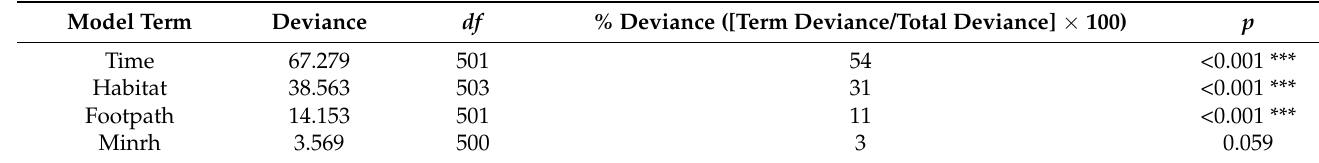
Table 3. Model effects for explanatory variables predicting dog ( Canis lupus familiaris ) presence/absence from point count transect data across 7 study sites in Brighton and Hove and surrounding areas, England, UK. Time = time of day (morning, day, evening); Habitat = habitat type (hardstanding, amenity grassland, natural grassland, woodland/scrub); Minrh = minimum relative humidity (%); Footpath = location on/off a footpath. Total deviance = the difference between null (660.02 on 507 df) and residual (536.46 on 500 df) deviance for model overall = 123.74. *** < 0.001.